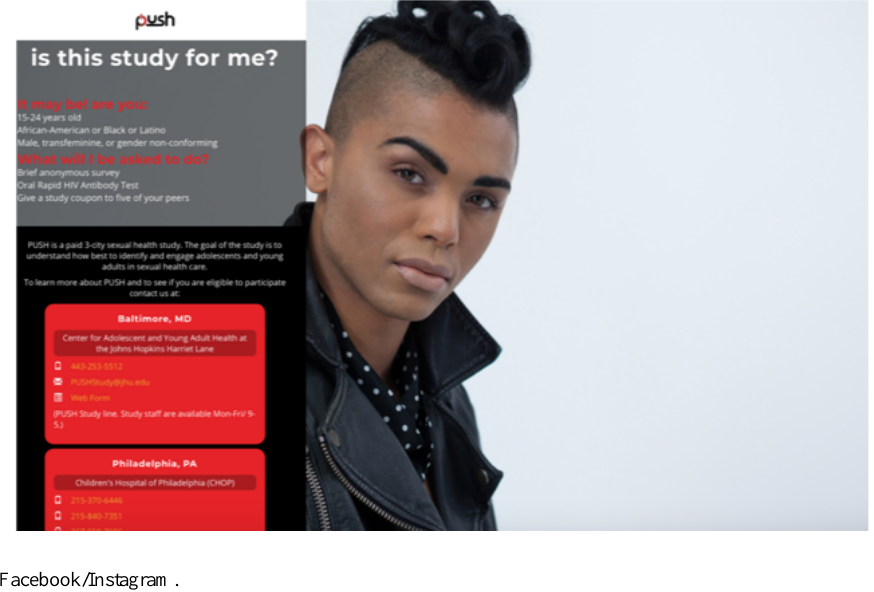
Figure 4. Example of